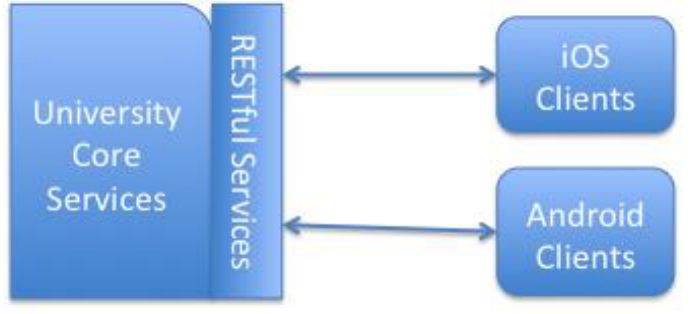
Figure 1 Communication with the campus applications